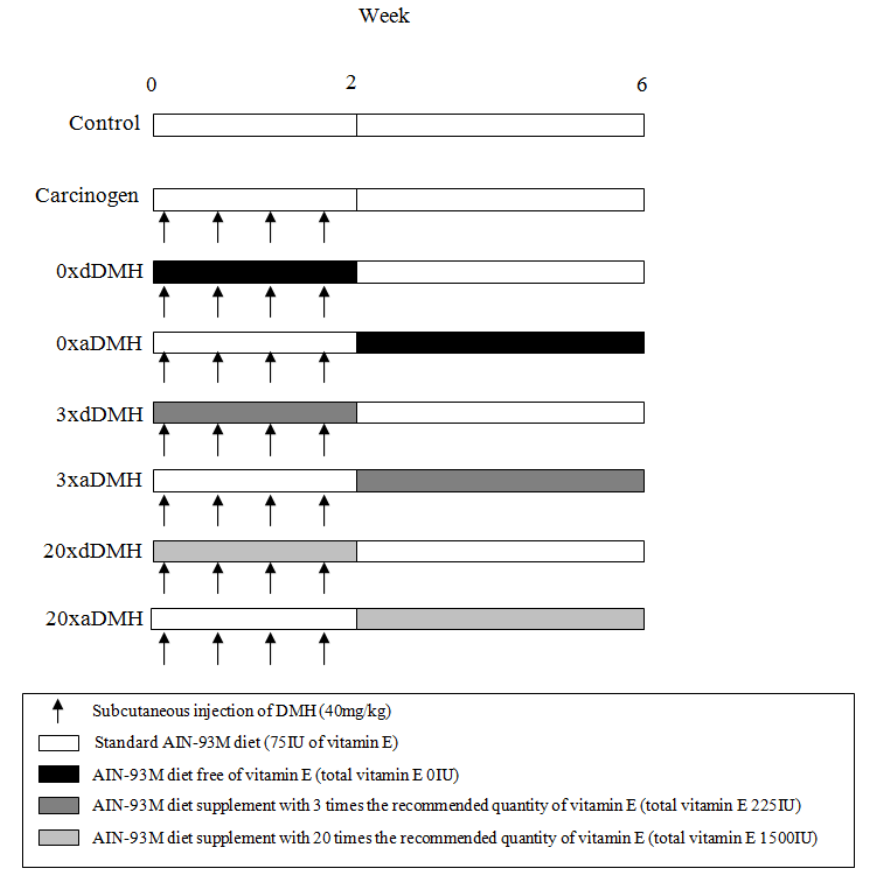
Figure 1. Experimental Design: During the first two weeks, all the groups (except for Control group) received four successive subcutaneous DMH injections. From the beginning until the third week, the 0×dDMH, 3×dDMH, and 20×dDMH groups received diets with different doses of VE (0, 225 IU, and 1500 IU, respectively). Thereafter, these groups received diet with 75 IU of VE up to the end of the experiment. The 0×aDMH, 3×aDMH, and 20×aDMH groups received diets with 75 IU of VE for the first two weeks. Then, from the third week up to the end of the experiment, these groups received diets with different doses of VE (0, 225 IU, and 1500 IU, respectively). The Control and Carcinogen groups received diet with 75 IU of Vitamin E during all the experimental period. All the groups